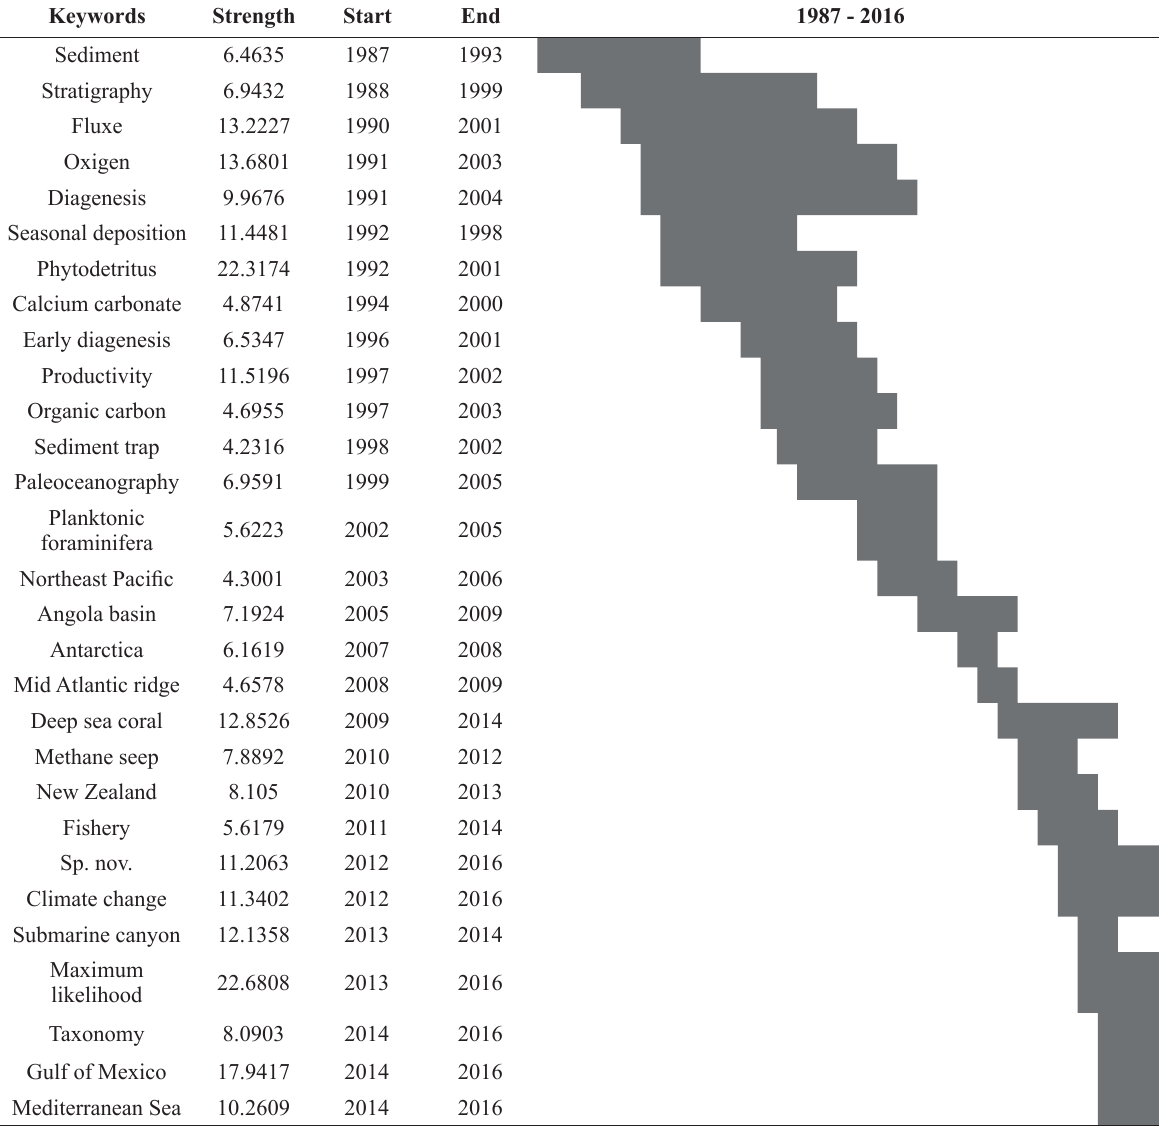
Emerging themes on the “deep sea” between 1987 and 2016. “Strength” represents the strength or vigor of a keyword’s appearance during the